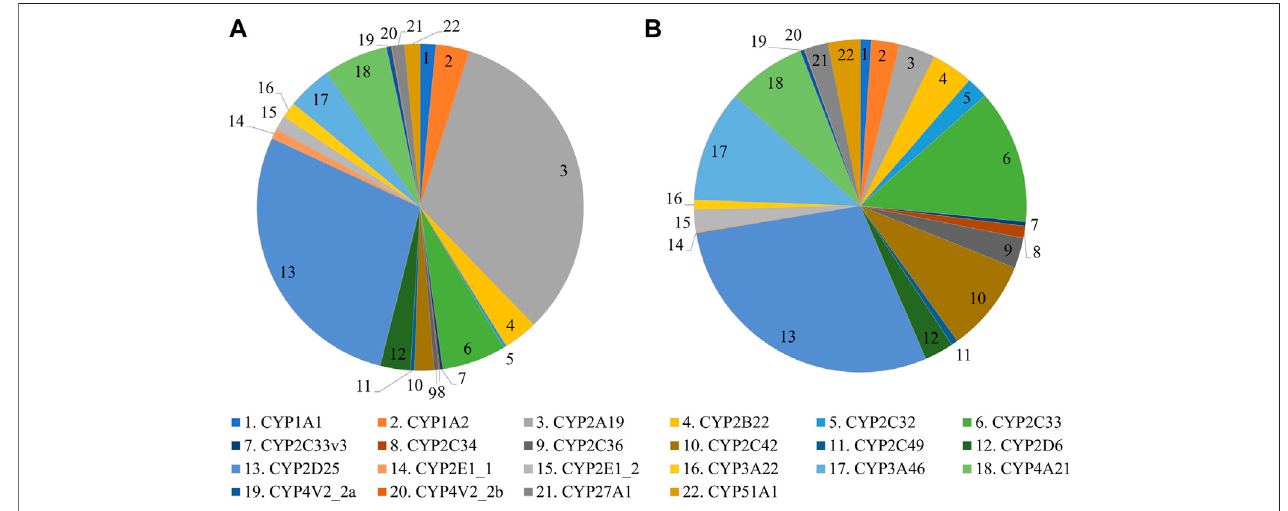
FIGURE 2 | CYP protein abundance pro fi le in adult female (A) and male (B) Göttingen